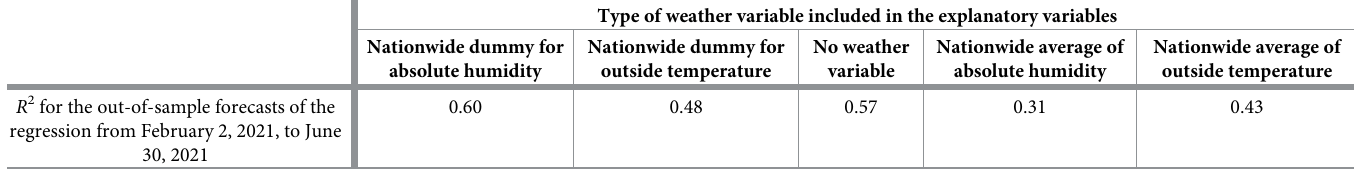
Table 3. R 2 for the out-of-sample forecasts of regressions with alternative weather variables for explanatory